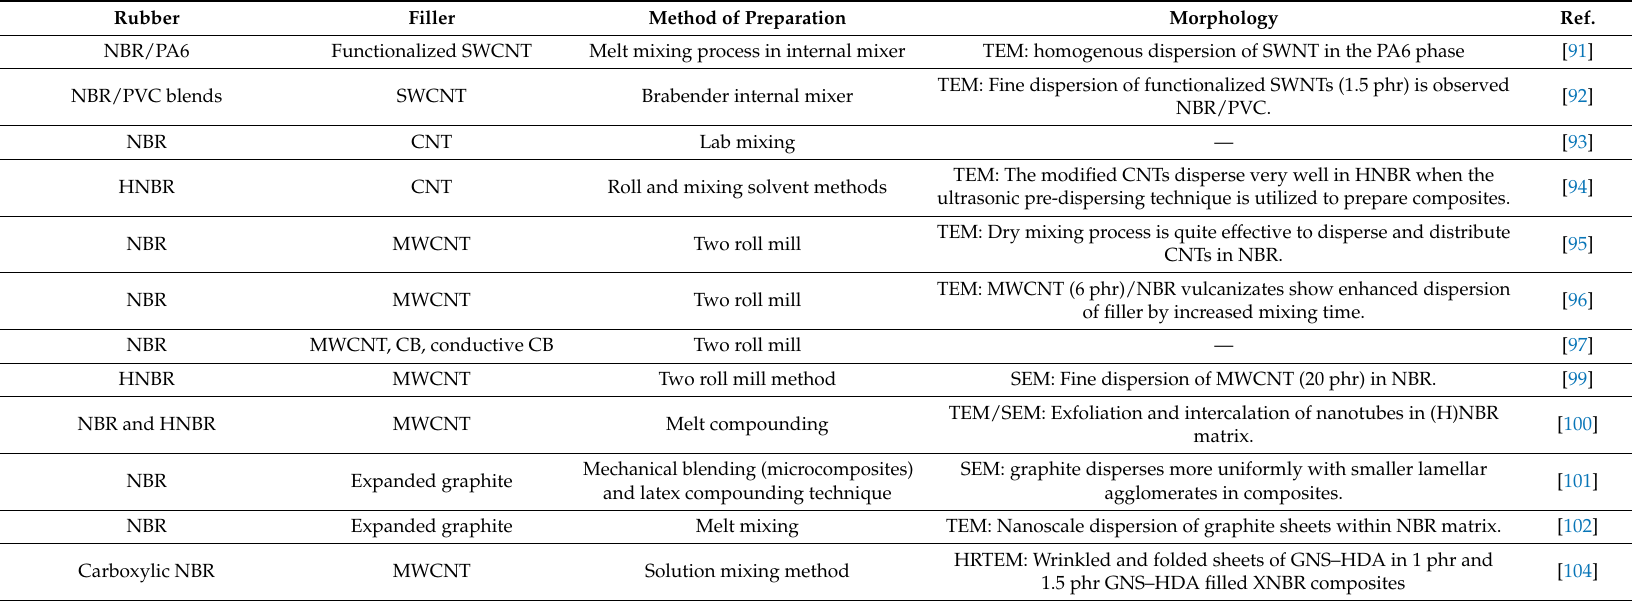
Table 3. Types of carbonaceous nano fillers, preparative methods adopted and morphology of NR